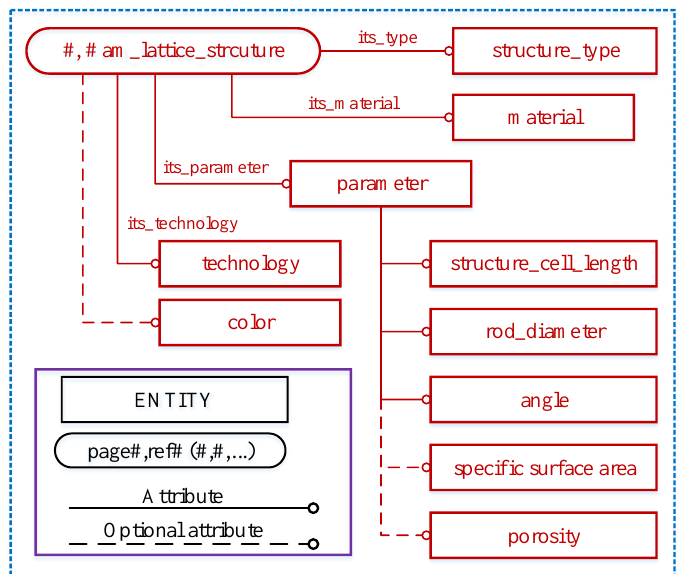
Figure 5. Data model for lattice structure based on EXPRESS-G